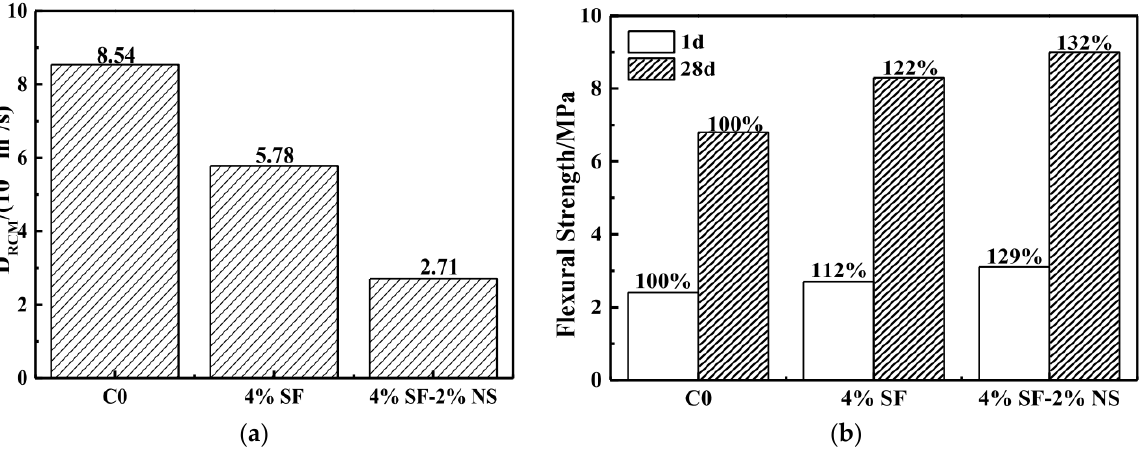
Figure 16. ( a ) Chloride diffusion coefficient of concrete coated by SPM for 28 days; ( b ) interfacial bond strength of matrix and SPM [74].